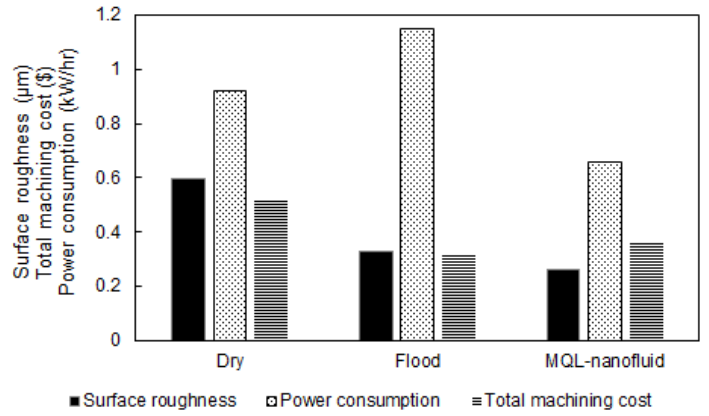
Figure 13. The selected optimal results for Model III (integrated performance-based model).